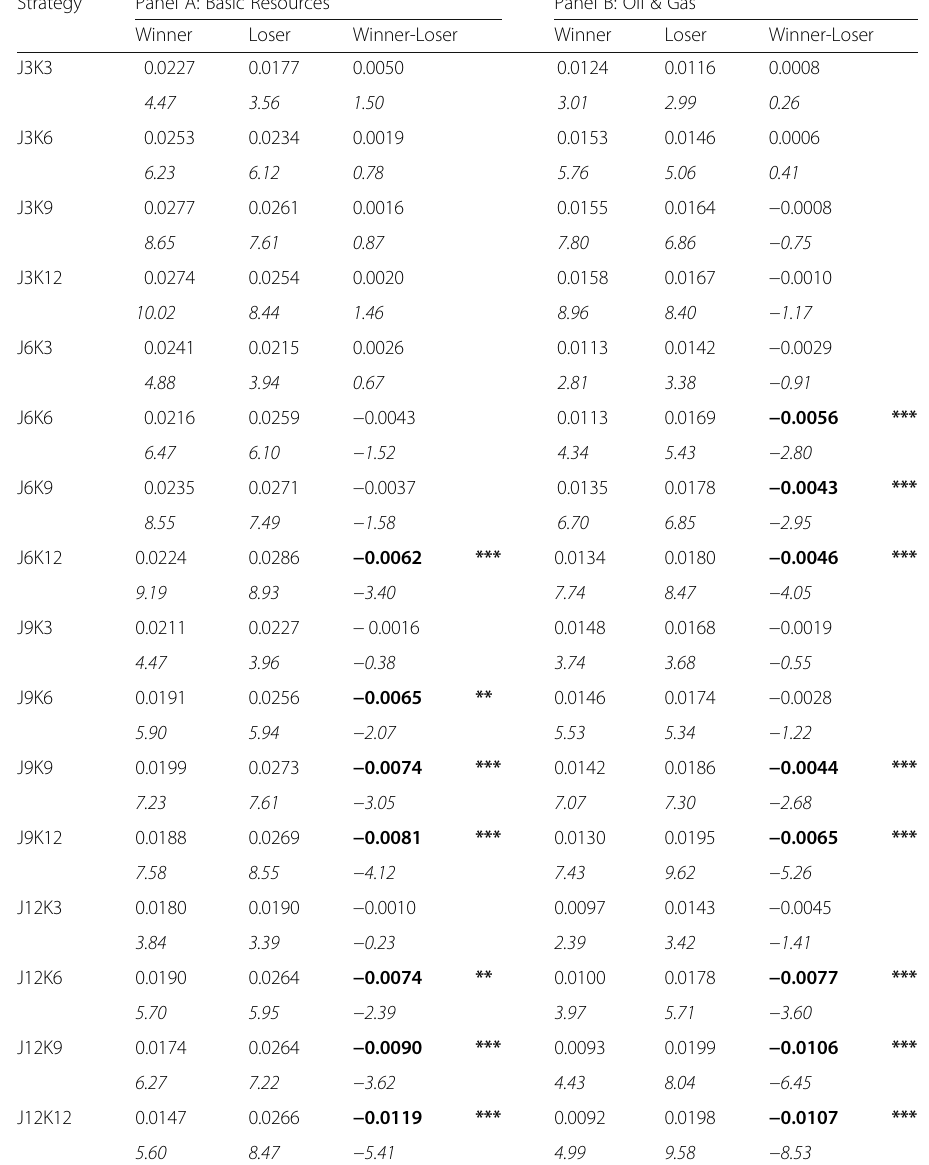
Table 4 (Part I). Industry-Neutral Momentum Portfolios Strategy Panel A: Basic